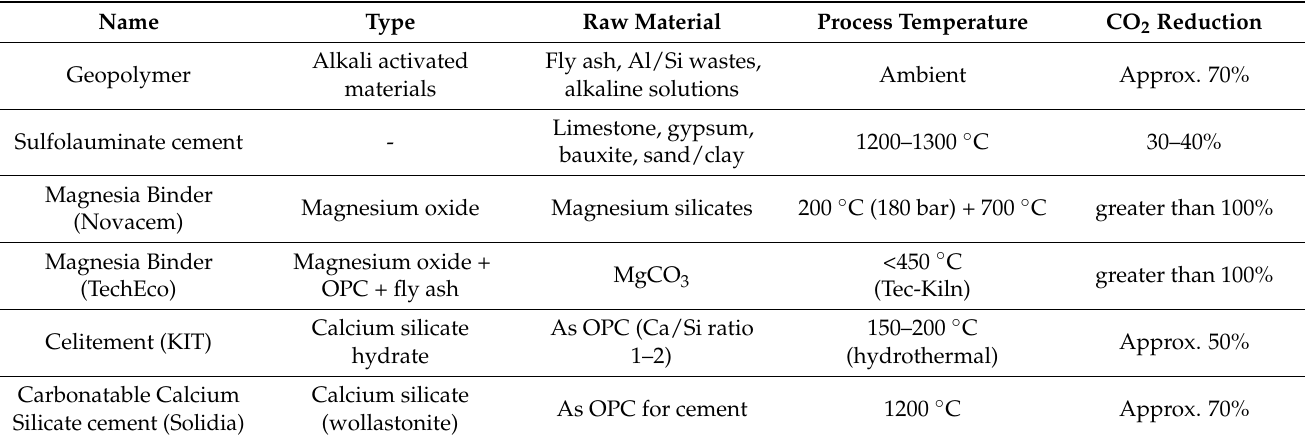
Table 1. Alternative cements for CO 2 reduction